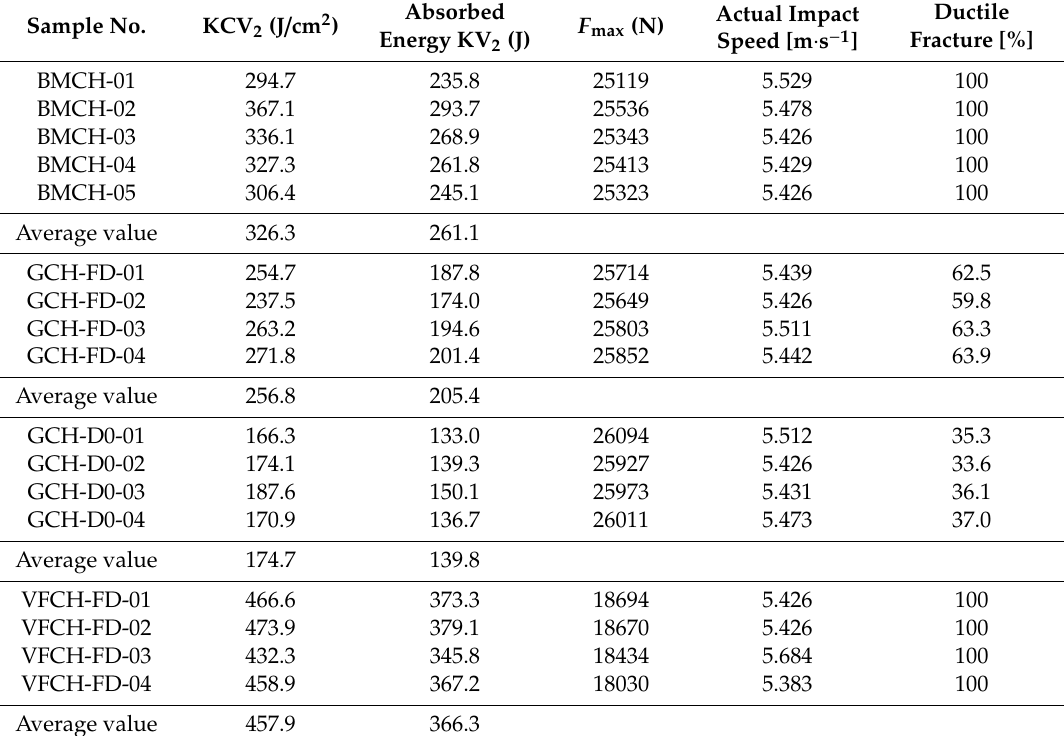
Table 6. Results of the Charpy impact test for the parent material and samples a ff ected by the temperature cycle under di ff erent conditions (a temperature of 23 ◦